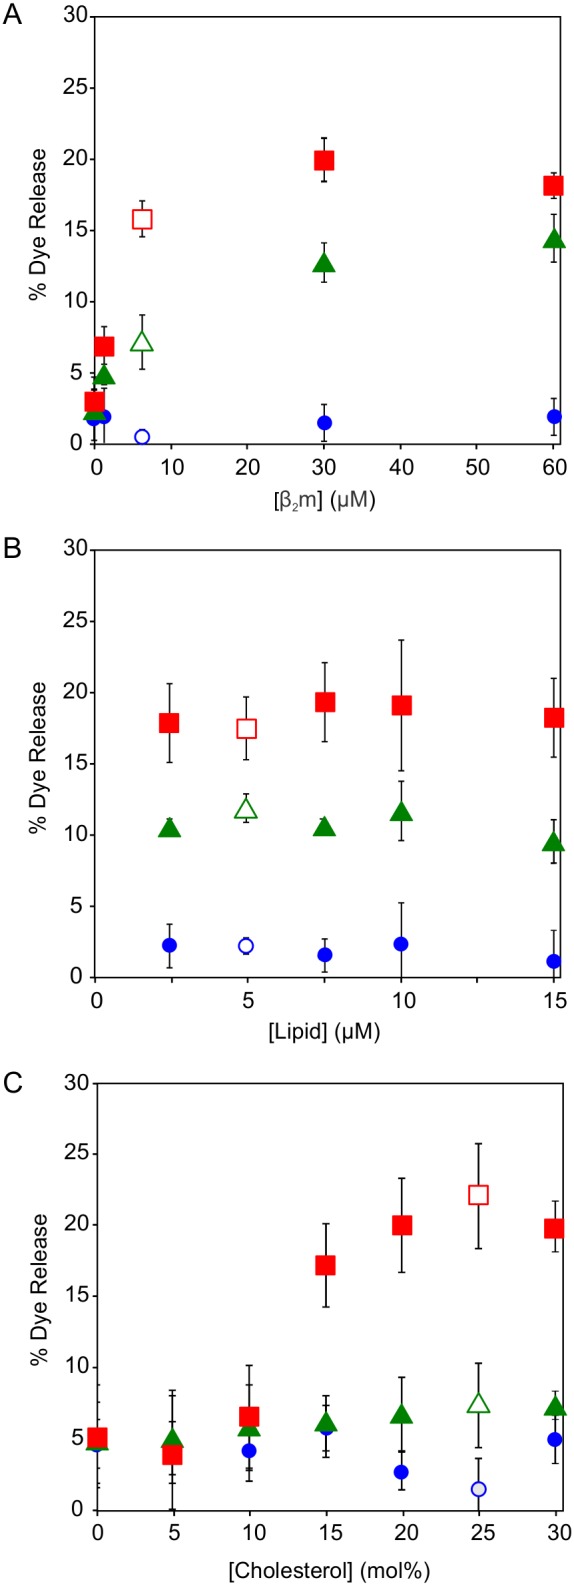
Dye release from LUVs comprised of 12 mol % BMP at pH 4.5, varying β2m: lipid concentration ratio and cholesterol content.(A) Dye release measured for LUVs (5 µM lipid) at different monomer equivalent concentrations of β2m. (B) Dye release measured for varying lipid equivalent concentrations of LUVs at 6 µM monomer equivalent concentration of β2m. (C) Dye release from LUVs (5 µM lipid) comprising 36 POPC: 20 POPE: 7 SM (mol/mol), 12 mol % BMP plus varying concentrations of cholesterol at 6 µM monomer equivalent concentration of β2m. Dye release was measured 10 min after addition β2m monomer (circle, blue), fragmented fibrils (square, red) and unfragmented fibrils (triangle, green) in Assay Buffer pH 4.5, 37°C. Error bars represent 1 S.D. from three replicates. Open symbols corresponds to dye release measured for 6 µM monomer equivalent β2m samples with 5 µM lipid equivalent concentration of LUVs containing 25 mol % cholesterol, as in Fig. 3.